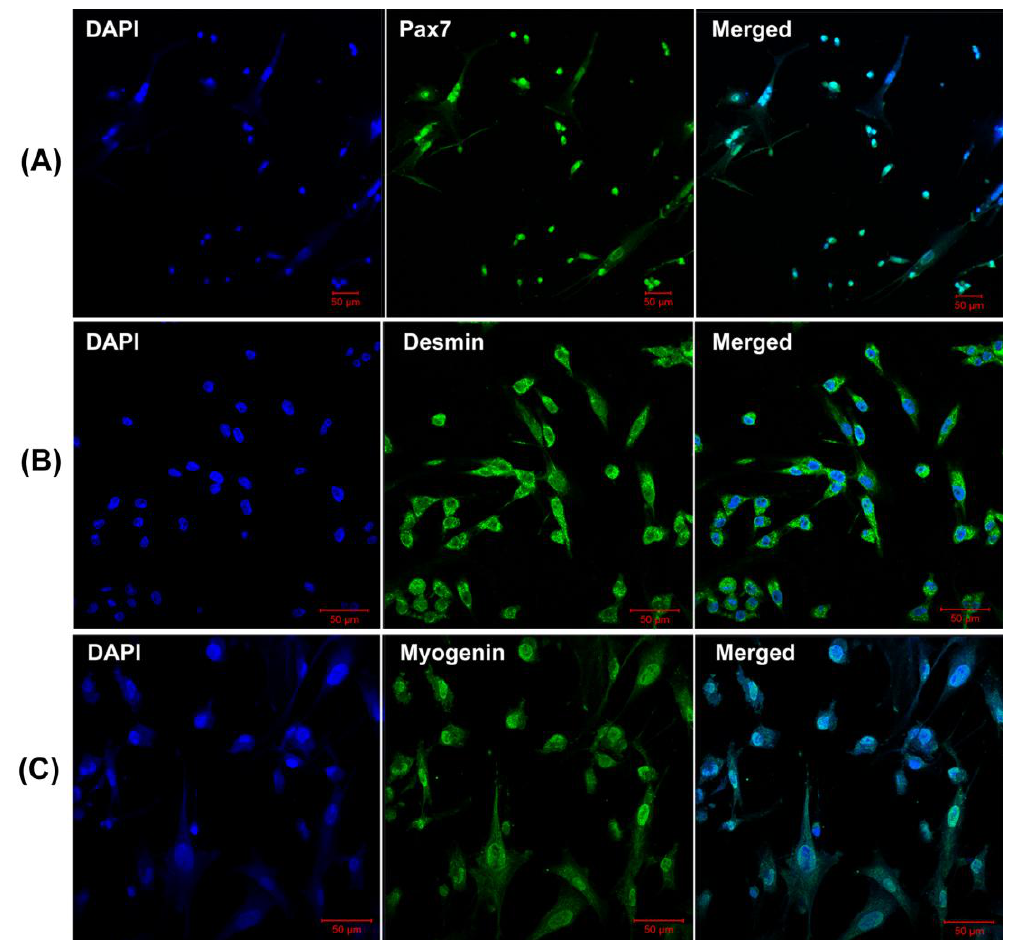
Figure 2. Characterization of porcine positive skeletal muscle satellite cells. (A) Immunofluorescence analysis of Pax7 expression on proliferating porcine skeletal muscle satellite cells. (B) Immunofluorescence analysis of Desmin expression on proliferating porcine skeletal muscle satellite cells. (C) Immunofluorescence analysis of myogenin expression on differentiated porcine skeletal muscle satellite cells. Bar = 50 μm.